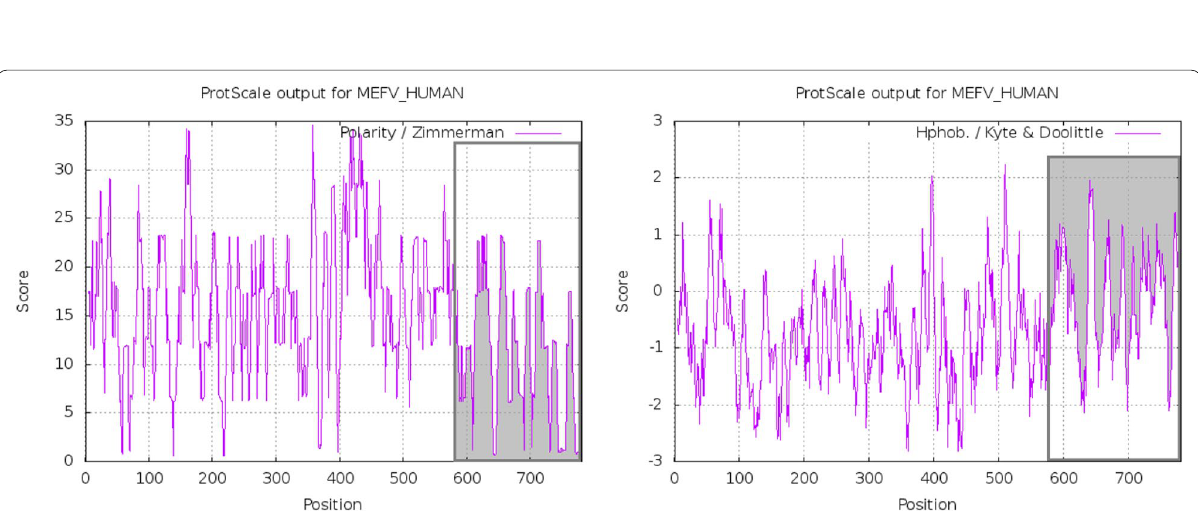
Fig. 2 Weighted scores of full‑length pyrin residues demonstrate that B30.2/SPRY residues, highlighted by the gray signal, are more to be classified as non‑polar hydrophobic residues according to the ProtScale